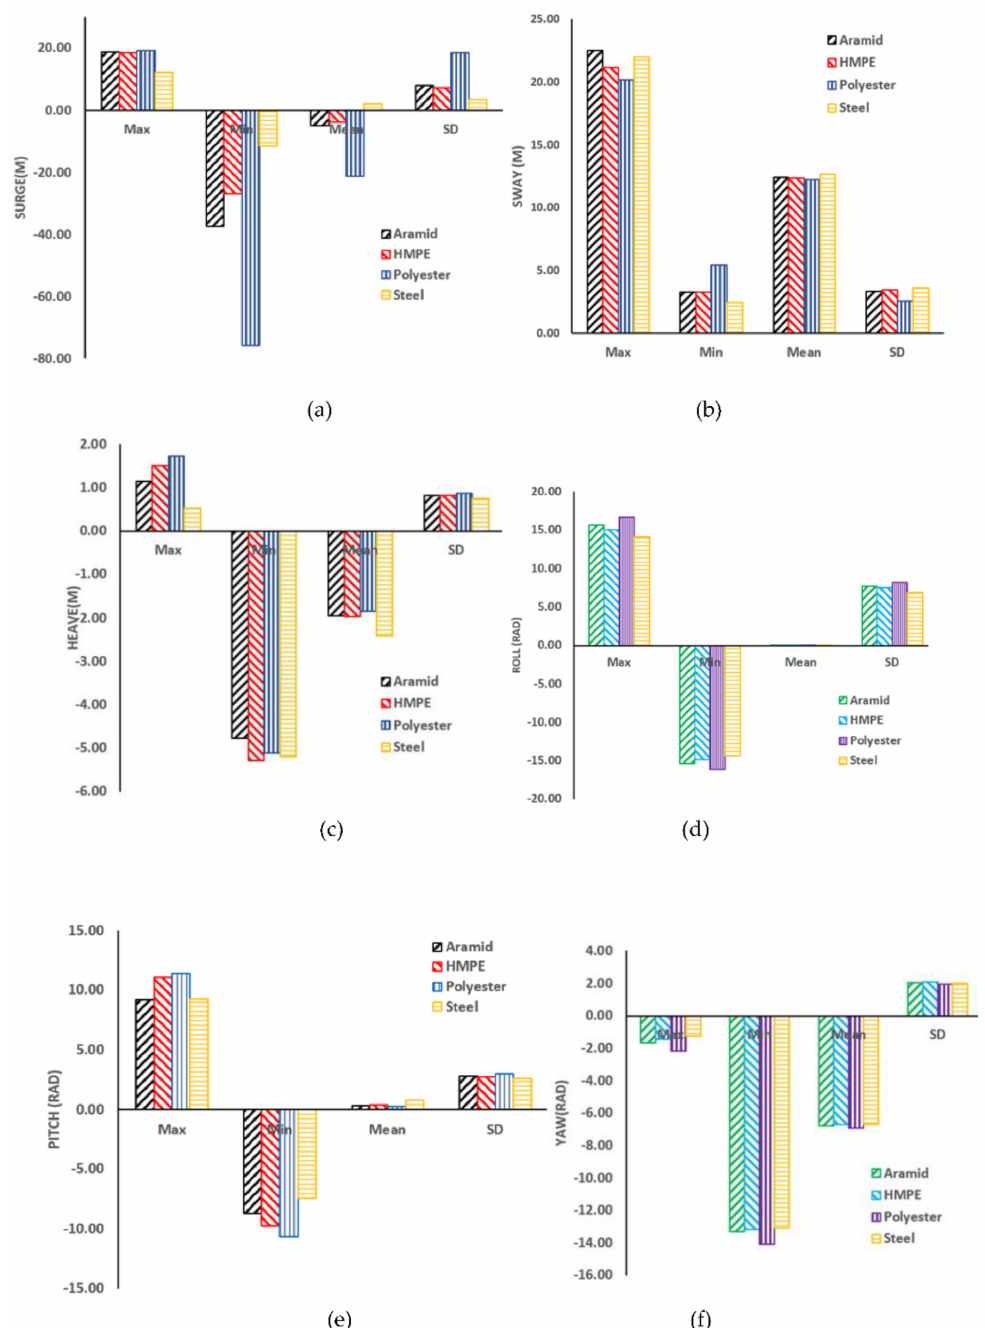
Figure 9. Statistical comparison of FPSO motion responses in 6 DOF considering different mooring materials in intact conditions: ( a ) surge; ( b ) sway; ( c ) heave; ( d ) roll; ( e ) pitch; ( f )